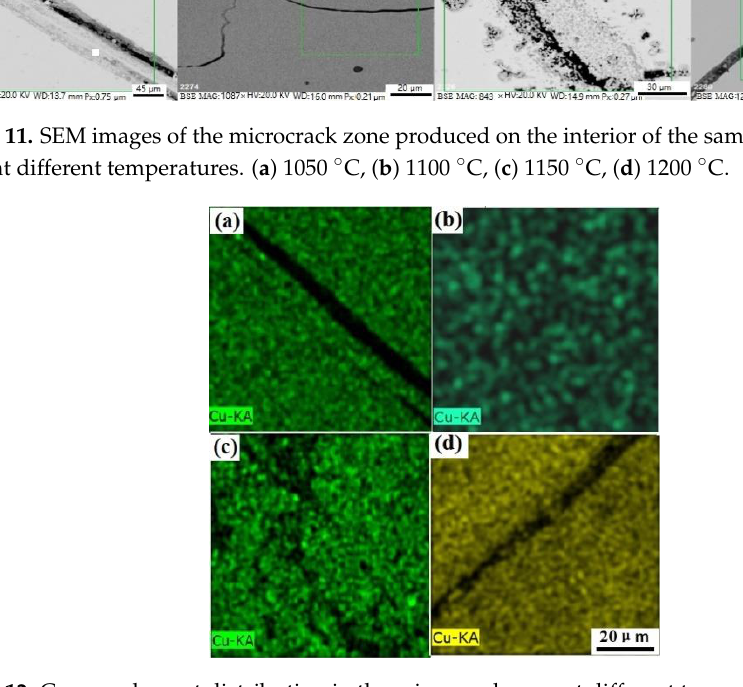
Figure 12. Copper element distribution in the microcrack zone at different temperatures ( a ) 1050 ◦ C, ( b ) 1100 ◦ C, ( c ) 1150 ◦ C, ( d ) 1200 ◦ C.